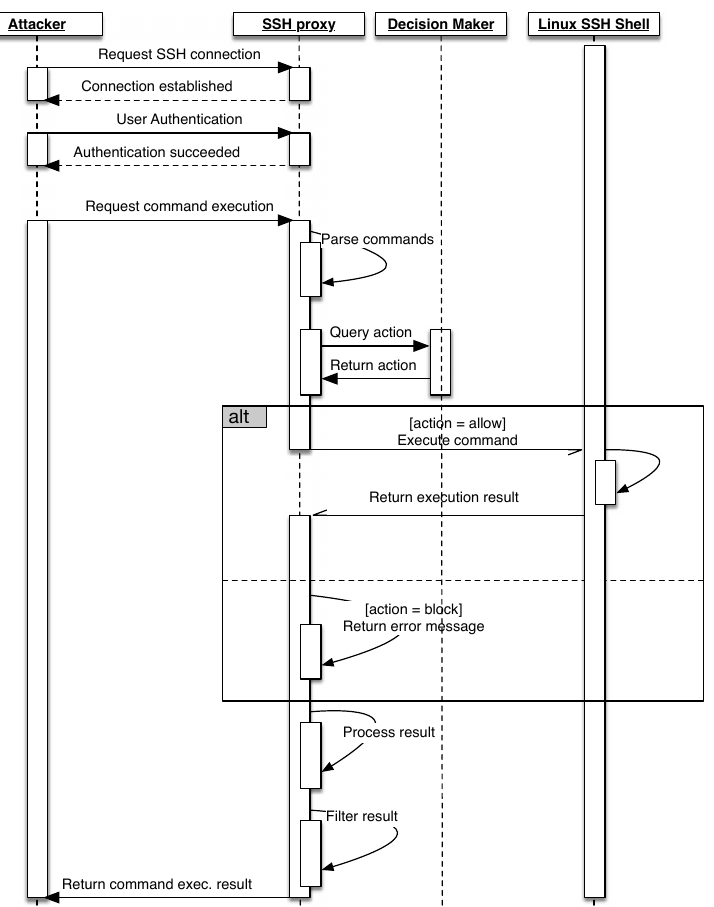
Figure 3. UML sequence diagram of the interaction between the attacker and